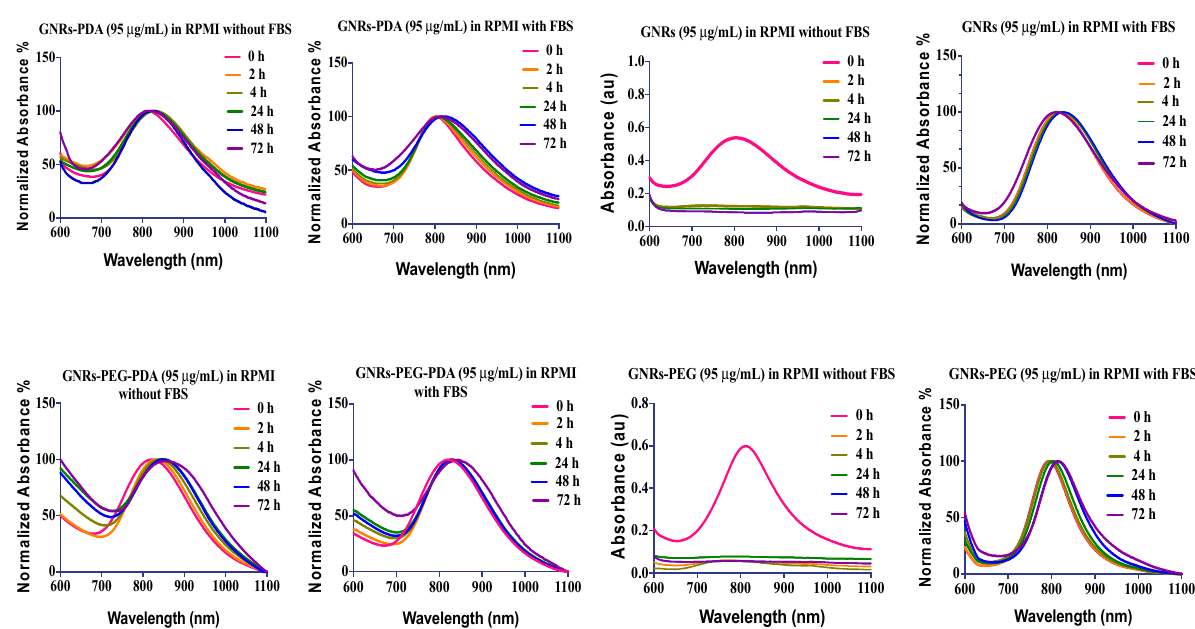
Figure 4. The longitudinal optical spectra of GNRs, GNRs-PEG, GNRs-PDA, GNRs-PEG-PDA dispersed in RPMI cell culture medium with and without addition of FBS after different incubation times.